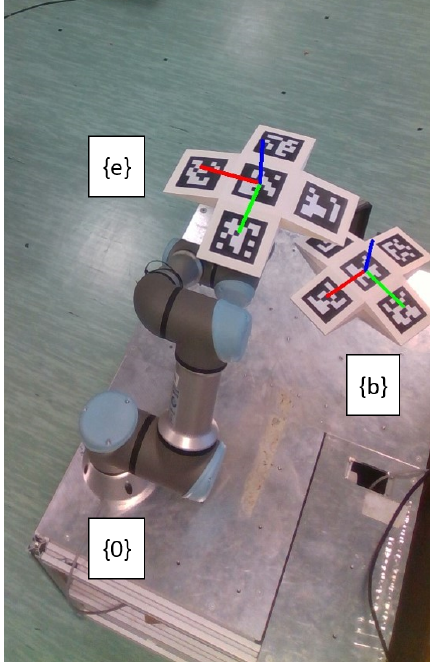
Figure 5. Experiment B